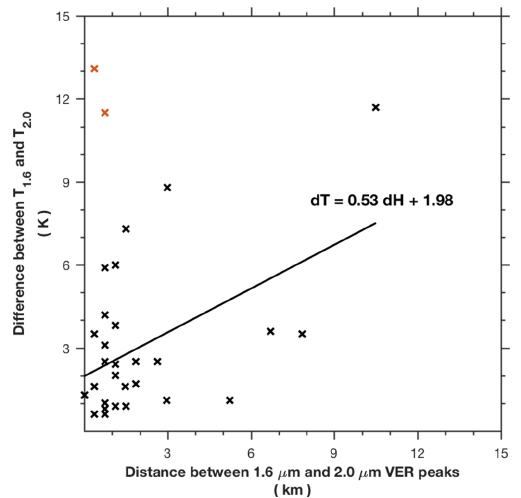
Figure 5. Scatter plot showing the dependence of the difference of T 1 . 6 and T 2 . 0 OH-equivalent temperatures on the separation of 1.6 and 2.0µm VER peaks.